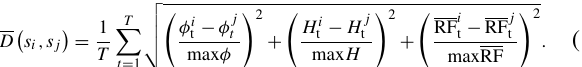
point in watts per square meter (W m − 2